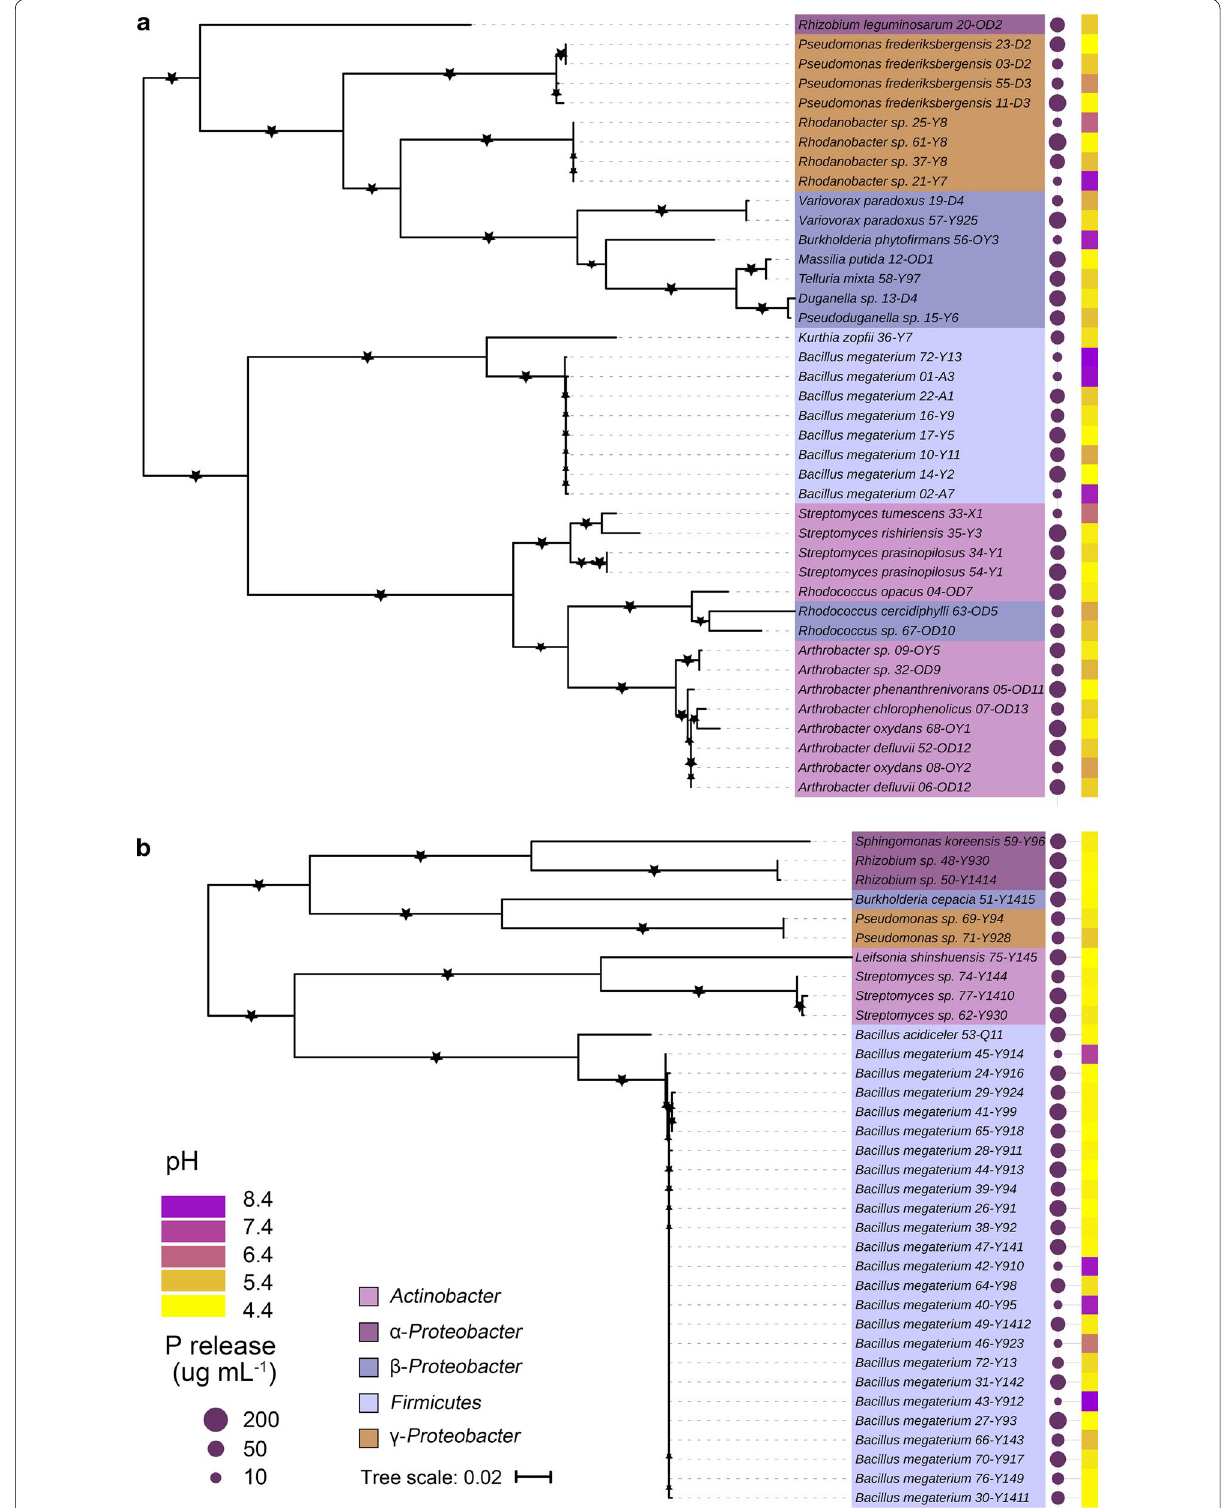
Fig. 3 Phylogenic trees of 76 iPSB strains from a Hailun and b Yingtan soil based on their 16S rRNA sequences. Maximum likelihood was used to construct the trees with bootstrapping (1000 replicates). Bootstrap percentages > 50% are marked with stars. The scale bar indicates 0.02 accumu‑ lated changes per nucleotide